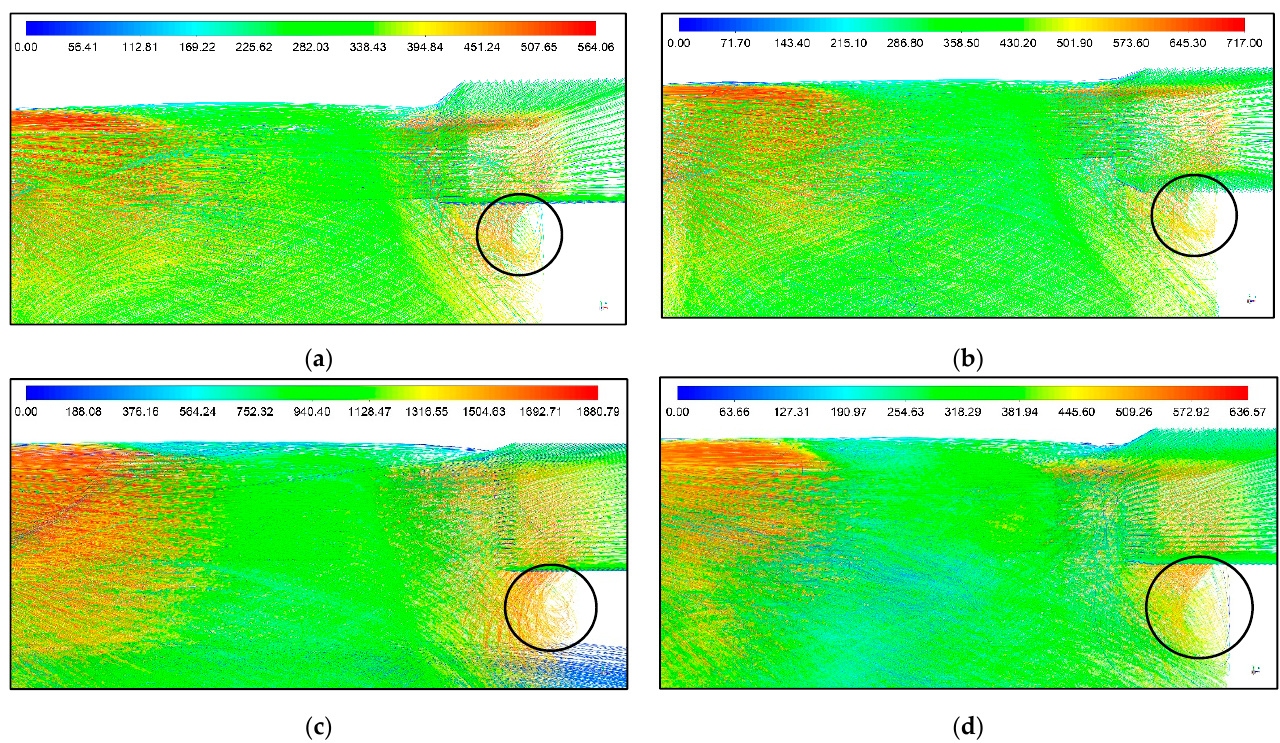
Figure 21. Velocity streamlines obtained for SVT with: ( a ) Ar ; ( b ) air ; ( c ) He ; and ( d ) CO 2 . The median section of a vortex also showed that its structure became less elongated than SVT with an inner body (Figure 22). The projected velocities have values close to the values for SVT with an inner body.